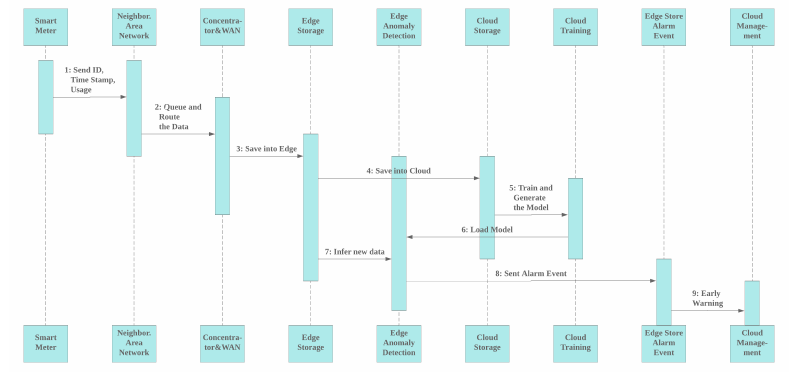
Figure 3. Sequence Diagram of Anomaly Detection System.